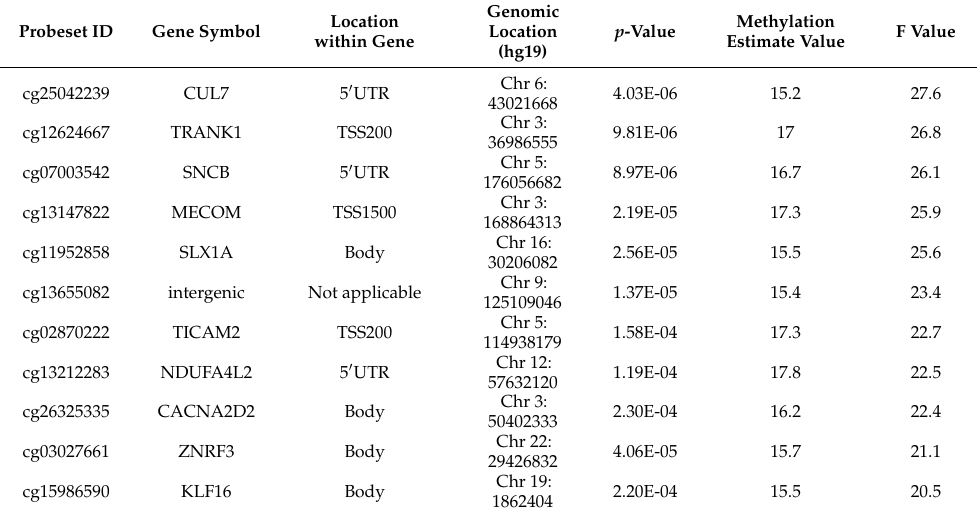
Table 1. CIMP epi-signature: top 11 CG sites that were differentially methylated in IDH-positive group versus IDH-negative